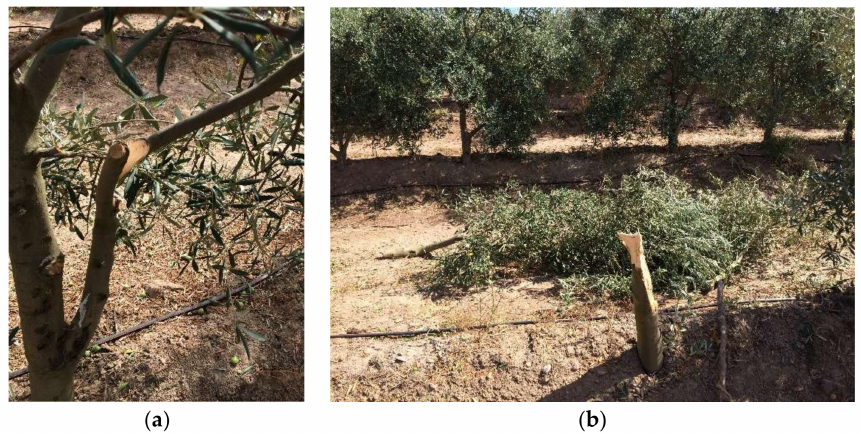
Figure 6. Olive tree with branch damage ( a ) and a tree tear ( b ) caused by the harvester in the same commercial field where the trials were